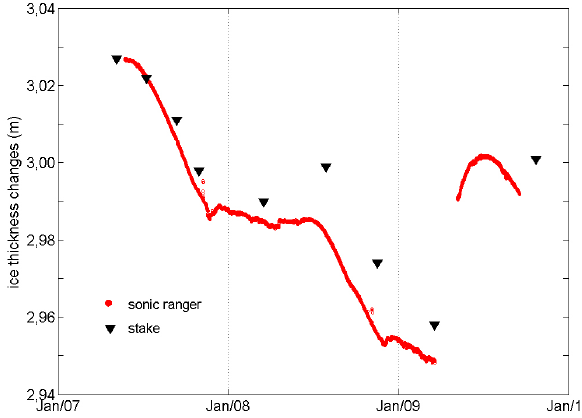
Fig. 10. Measured changes in ice thickness during two successive years indicating a strong influence of seepage water in spring 2009. Dashed lines mark the period of the reference